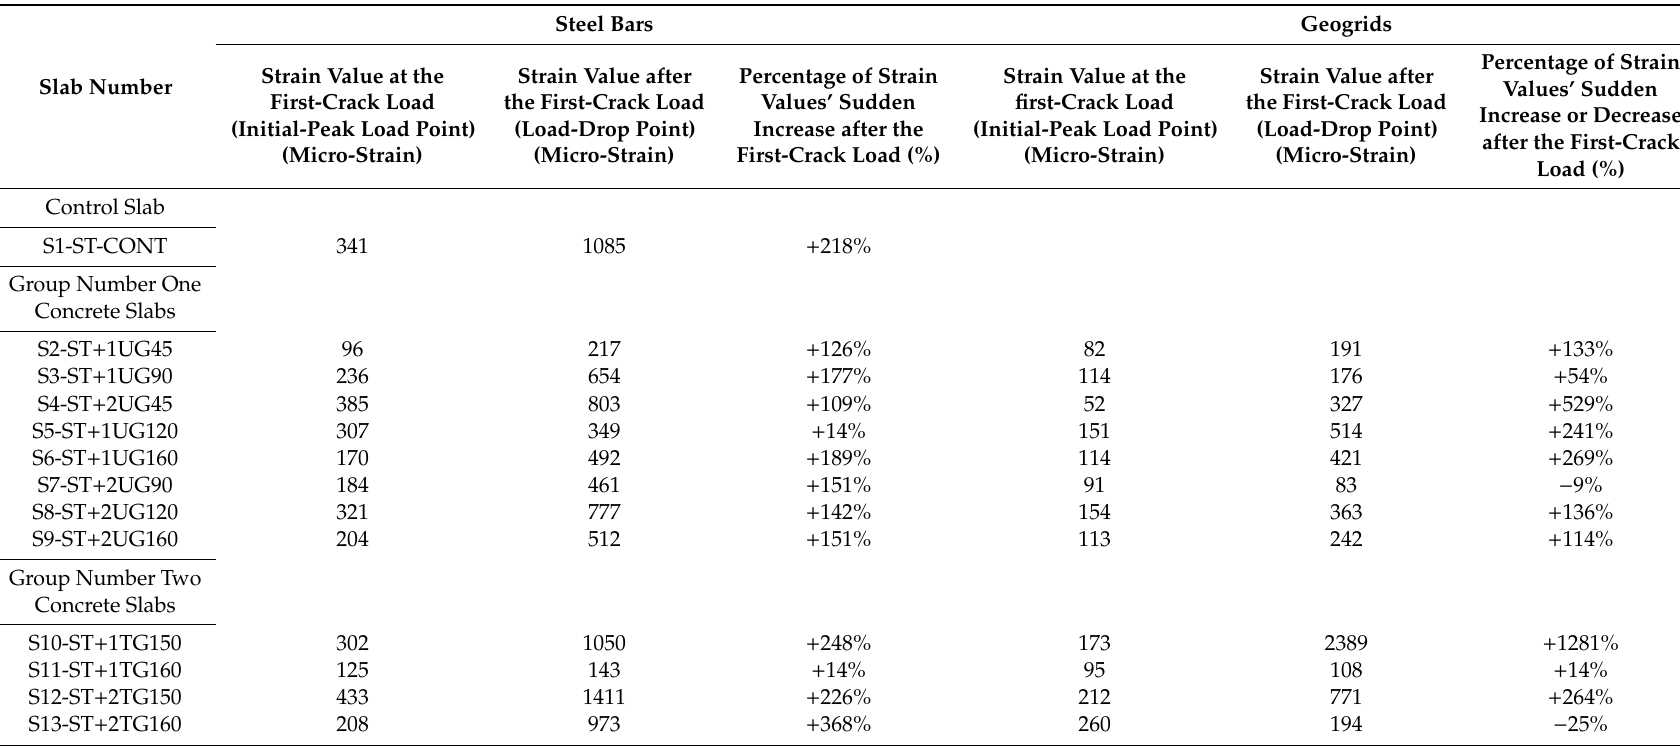
Table 6. Bottom reinforcement strain values’ records at the first-crack (initial-peak load) and after the first-crack